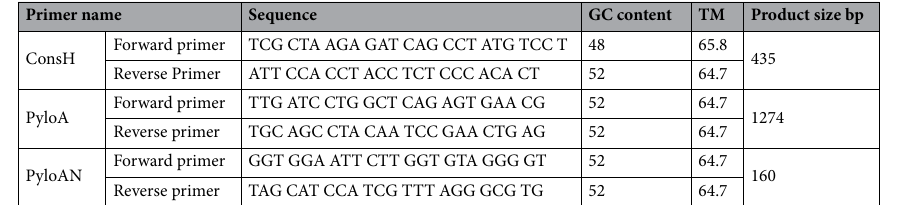
Table 2. Sequence of the newly designed primers in the